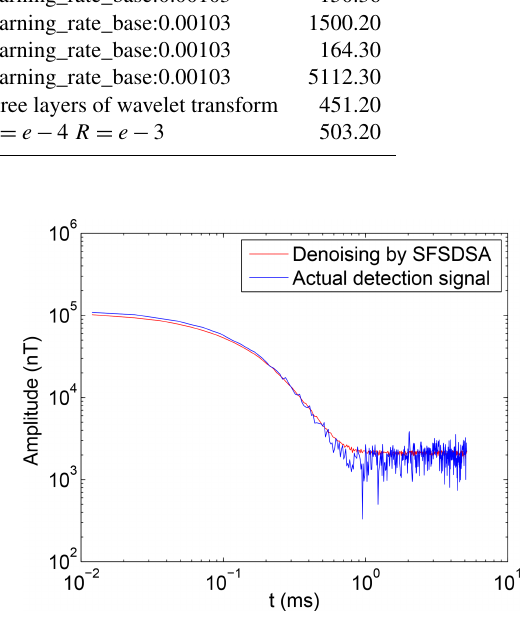
Figure 8. Actual secondary field data after SFSDSA model noise reduction.